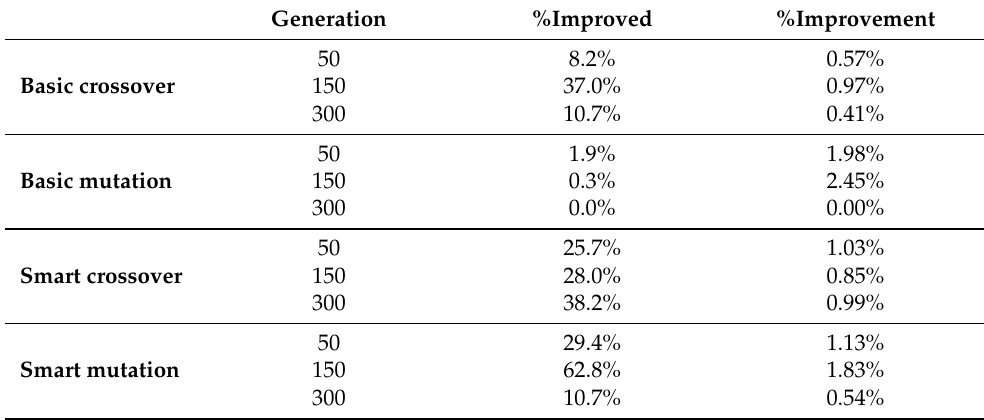
Table 3. Results: Genetic operators applied 1000 times to best two individuals at generations 50, 150, and 300. %Improved: Percentage of 1000 times the operator improved fitness. %Improvement: Average improvement of those that were improved by operator, i.e., of %Improved